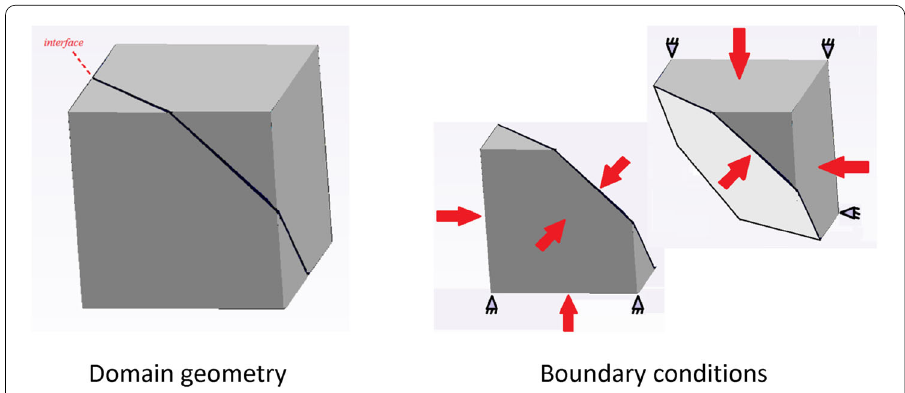
Fig. 29 3D test-case with quadratic elements. The strategies to improve the condition number are assessed on a 3D